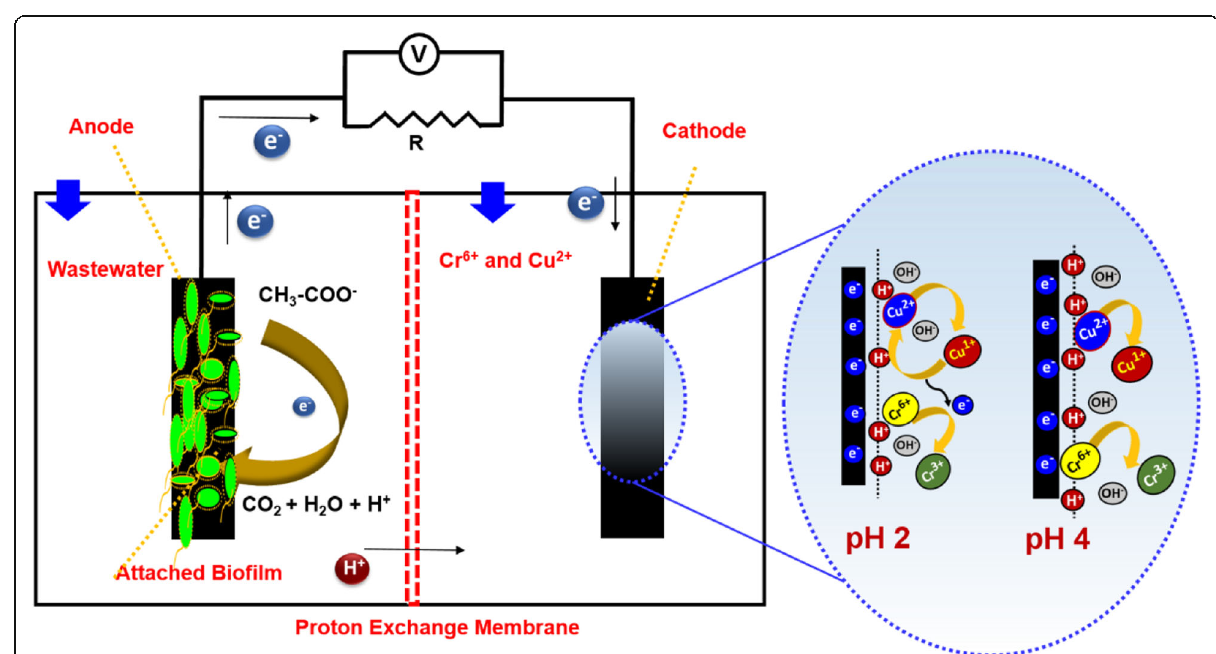
Fig. 3 The proposed mechanism for the reduction of Cr 6+ and Cu 2+ at pH 2 and